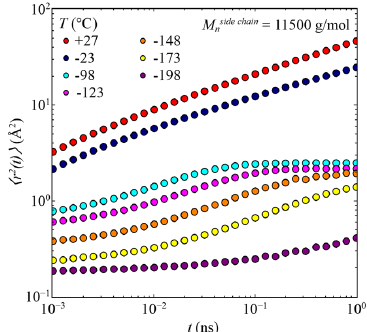
Fig. 12. Mean square displacement, ⟨𝑟 (cid:2870) (cid:4666)𝑡(cid:4667)𝑡⟩ , as a function of time, 𝑡 , for Sample 3 at different temperatures as indicated. Data has been previously published at Bichler et al .[22]